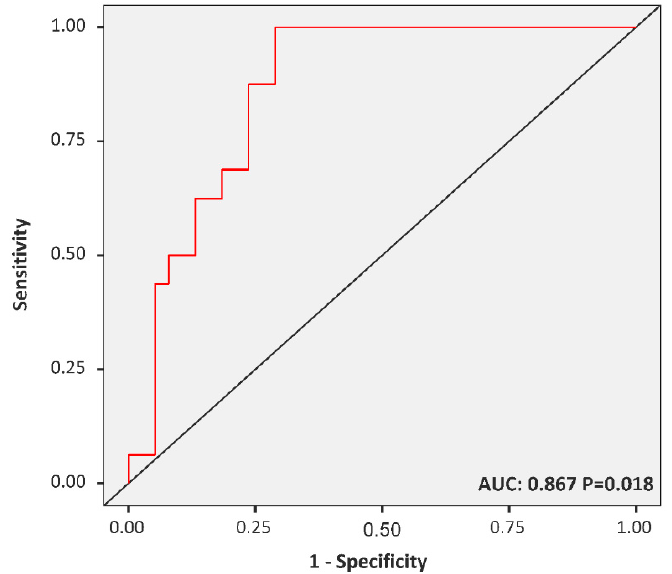
Figure 2. Receiver operating characteristic curve of the fetuin-A-to-adiponectin ratio for identifying children with metabolic syndrome. The optimal cut-off points and area under the curves (sensitivity, specificity) were 284.91 and 0.87 (0.25, 0.94) for diabetic children.